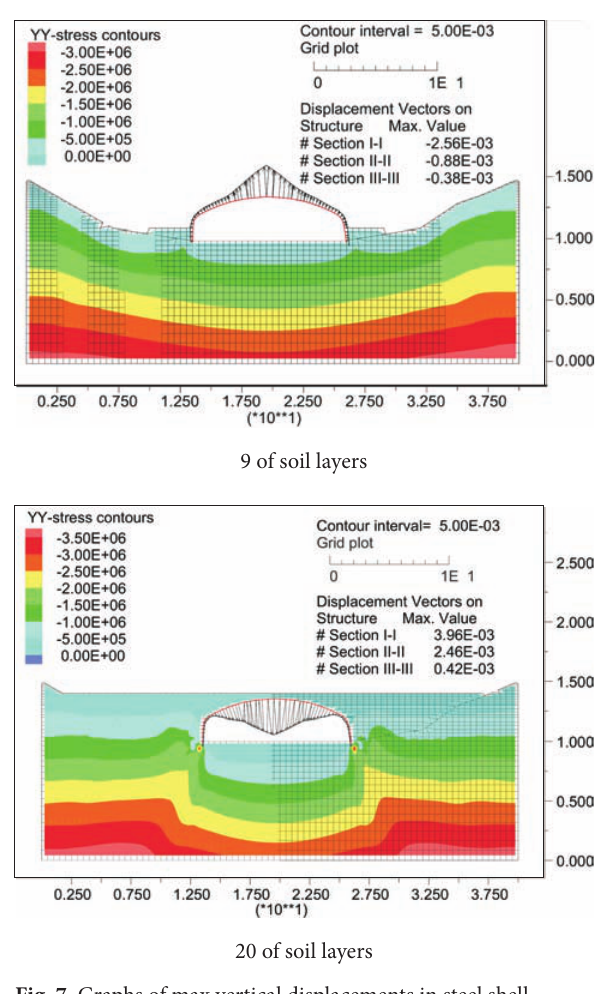
fig. 7. Graphs of max vertical displacements in steel shell structure obtained from backfilling and compacting the